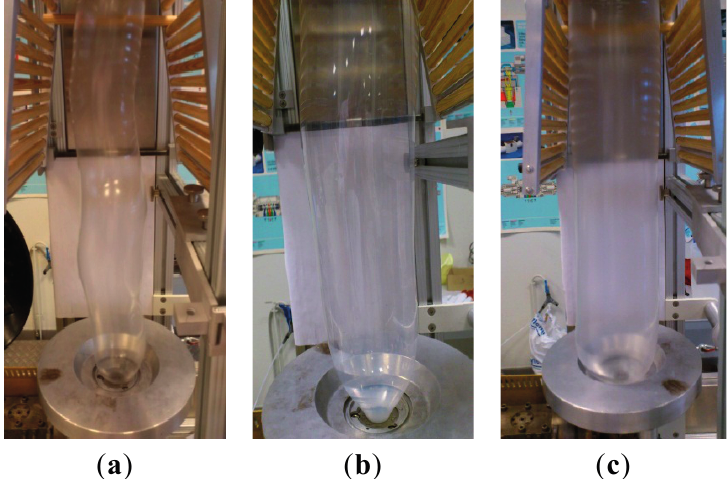
Figure 16. Comparison of the bubble shape between ( a ) PLA; ( b ) PLA–PBAT and ( c )